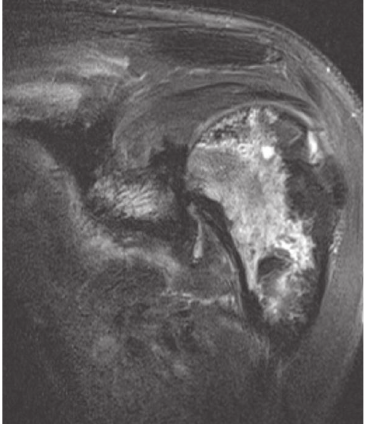
Figure 6: CT lumbar spine without contrast approximately 8 months since the initial presentation shows continued progression of diffuse osteonecrosis of the visualized marrow. The bone marrow is abnormal with multiple foci of gas.